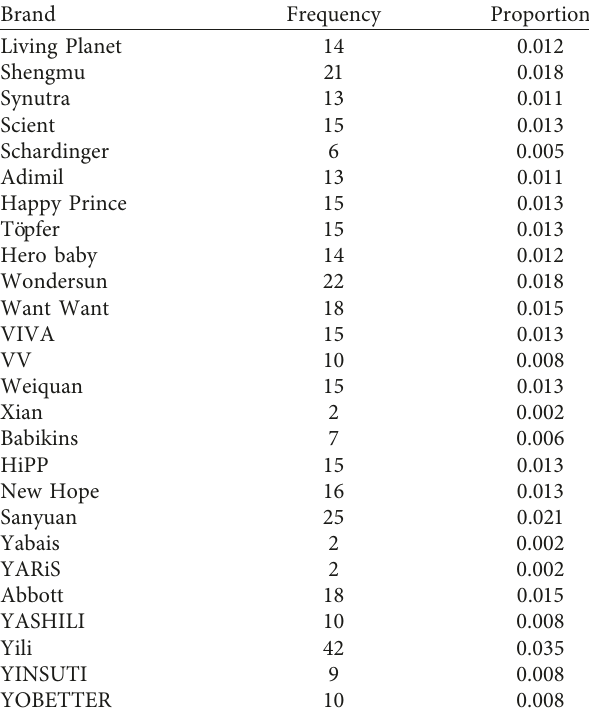
Table 4: Characteristics of dairy brands sampled on